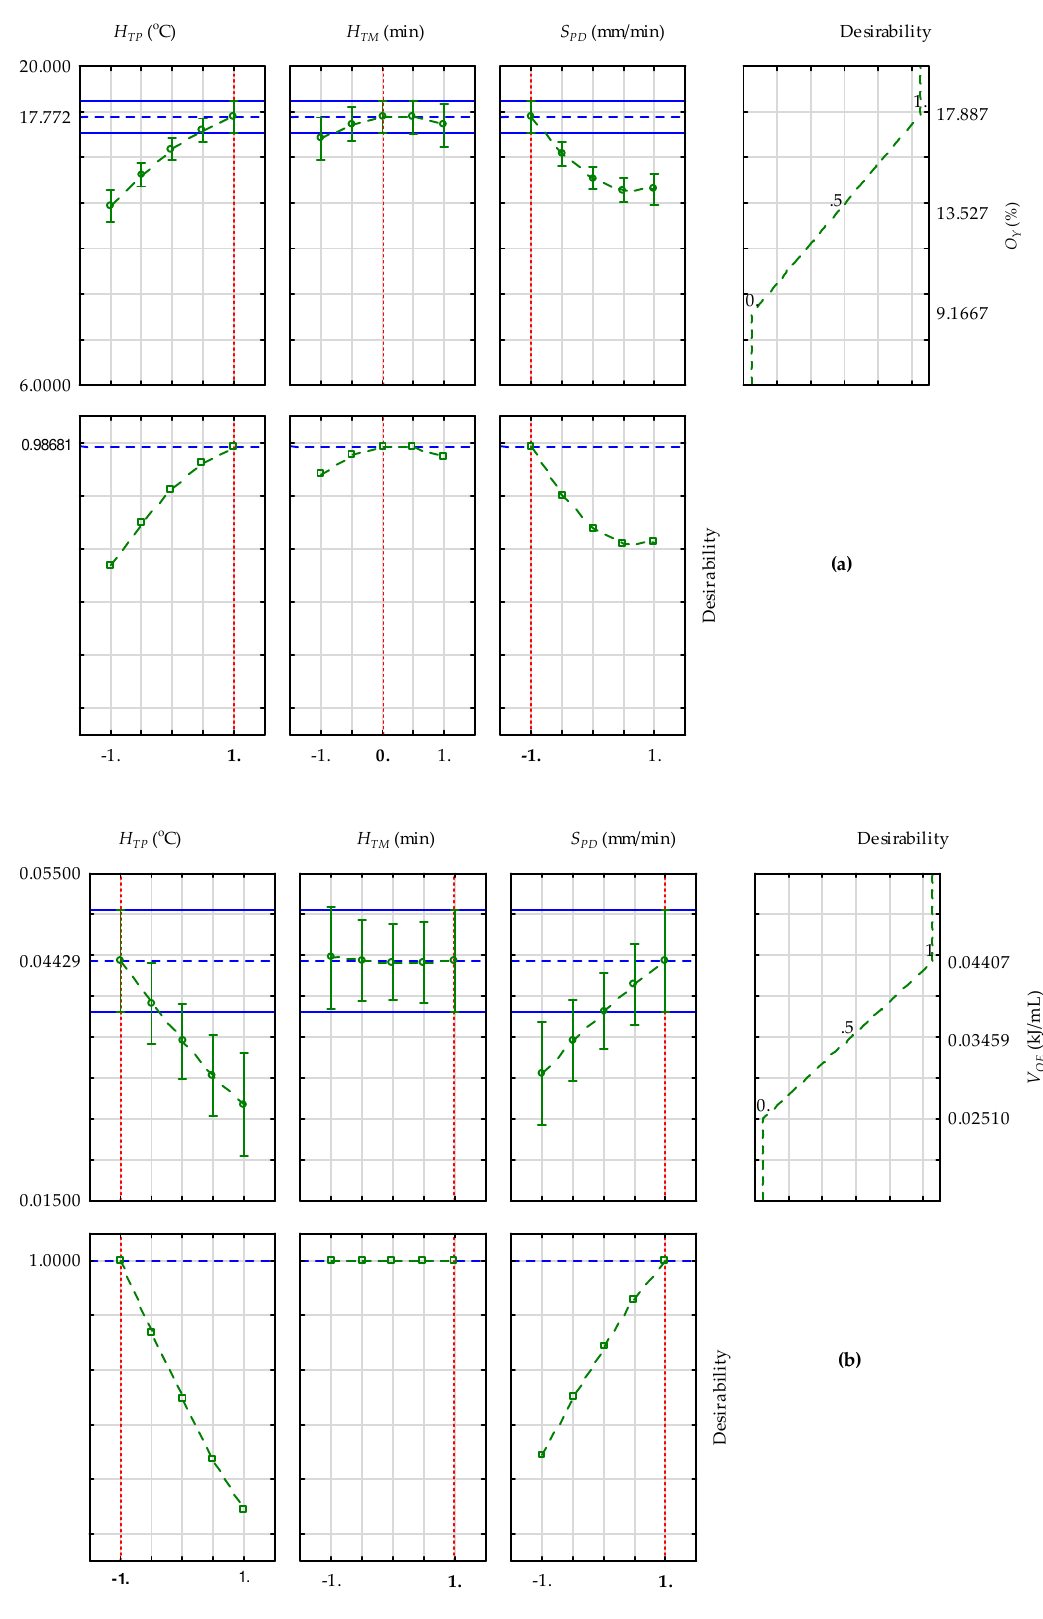
Figure 6. Predicted and desirable values of ( a ) O Y , oil yield, and ( b ) V OE , the volume of oil energy under heating temperatures ( O Y : H TP : +1 = 80 ◦ C; H TM : 0 = 30 min and S PD : − 1 = 5 mm/min; V OE : H TP : − 1 = 40 ◦ C; H TM : +1 = 45 min and S PD : +1 = 15